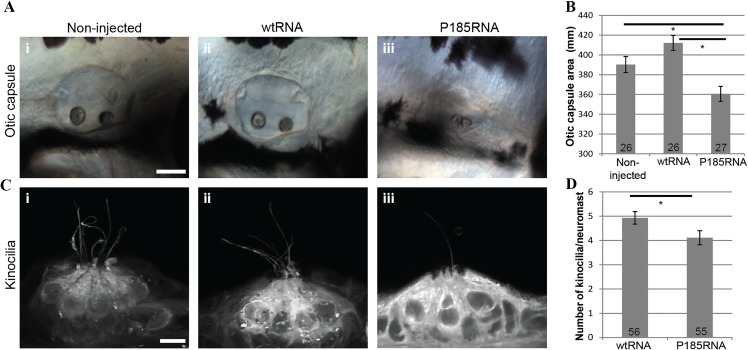
Over-expression of wtRNA and P185RNA in zebrafish embryos.
(A) Otic capsule morphology in non-injected (i, n = 26), wtRNA-injected (ii, n = 26) and P185RNA-injected (iii, n = 27) embryos at 72 hpf. Scale bar represents 50μm. Embryos are mounted anterior to the left. (B) Comparison of otic capsule morphology between WT and mutant RNA injected zebrafish shows reduced inner ear size in mutant RNA injected larvae (p<0.001). (C) Hair cell kinocilia in P185RNA-injected larvae (iii) show fewer kinocilia as compared to non-injected (i) and wtRNA-injected larvae (ii). Scale bar represents 5μm. (D) Kinocilia count per neuromast comparison between wtRNA-injected (n = 56) and P185RNA-injected (n = 55). All data are presented as the mean ± SEM and are derived from at least triplicates (*P < 0.05 as compared with controls considered significant).